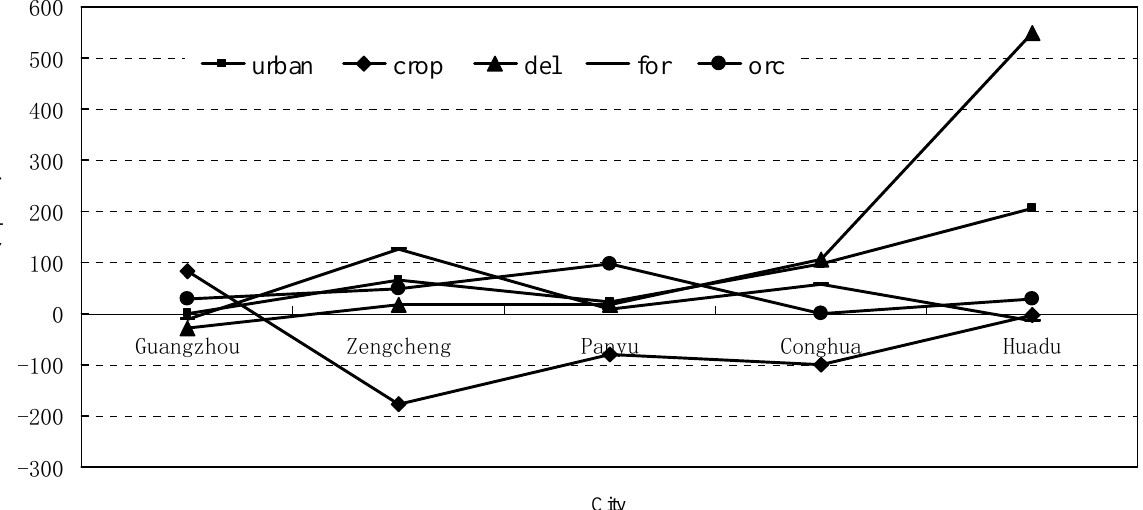
Figure 3. The changing rates of urban/built-up, cropland, developing/barren land, forest and orchard in five cities of